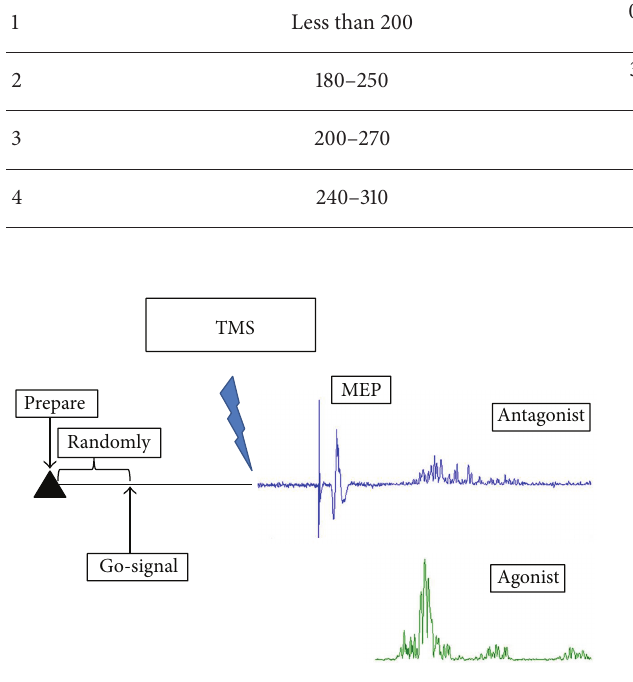
Figure 2: The procedure of the premovement MEP